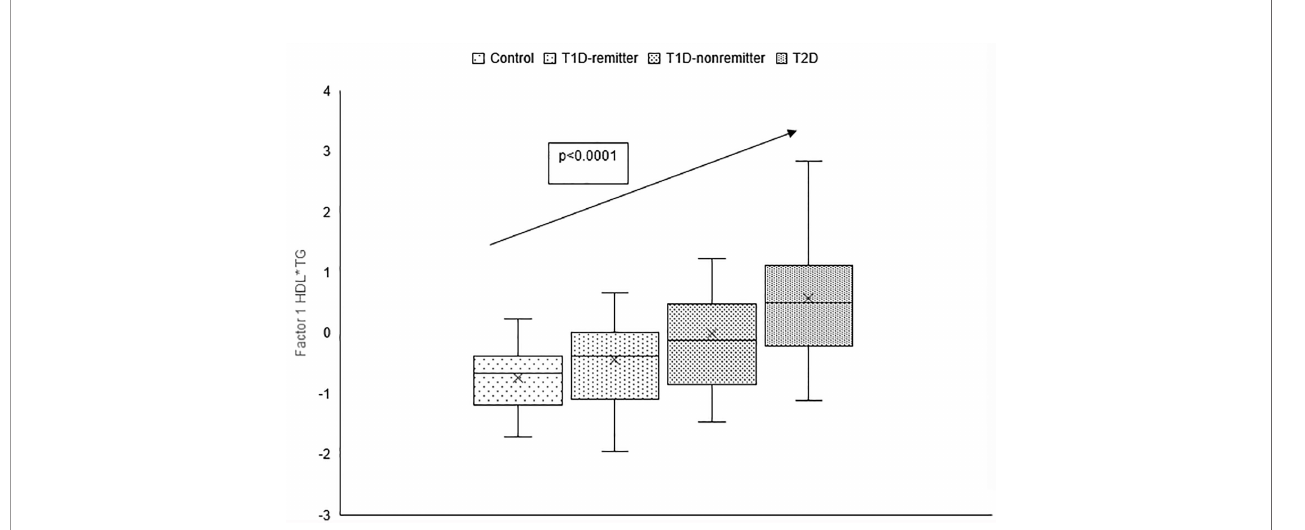
FIGURE 5 | Box plots of the factorial analysis of non-HDL-C, LDL-C, TC, TC/HDL ratio designated as summary factor 1 (TC*LDL) obtained with the factor loading threshold of ≥ 0.45 in 203 adults. Factor 1 explained 90% of the variance in the original lipid parameters with a linear increase in mean composite scores from controls, remitters, non-remitters, and subjects with type 2 diabetes (p=0.0042).